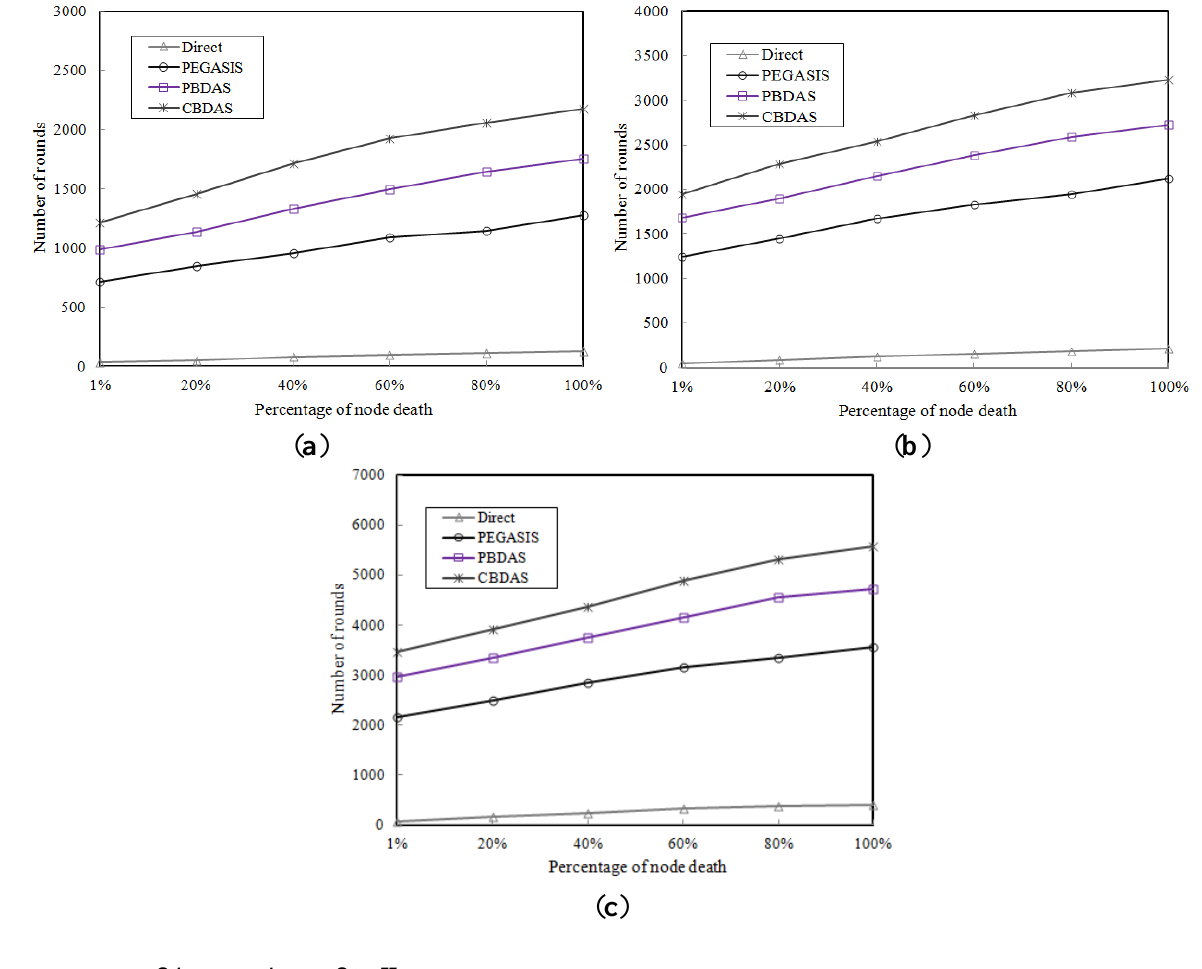
Figure 5. Number of rounds when 1%, 20%, 50%, and 100% nodes die. ( a ) Each node with initial energy 0.25 J; ( b ) Each node with initial energy 0.5 J; ( c ) Each node with initial energy 1.0